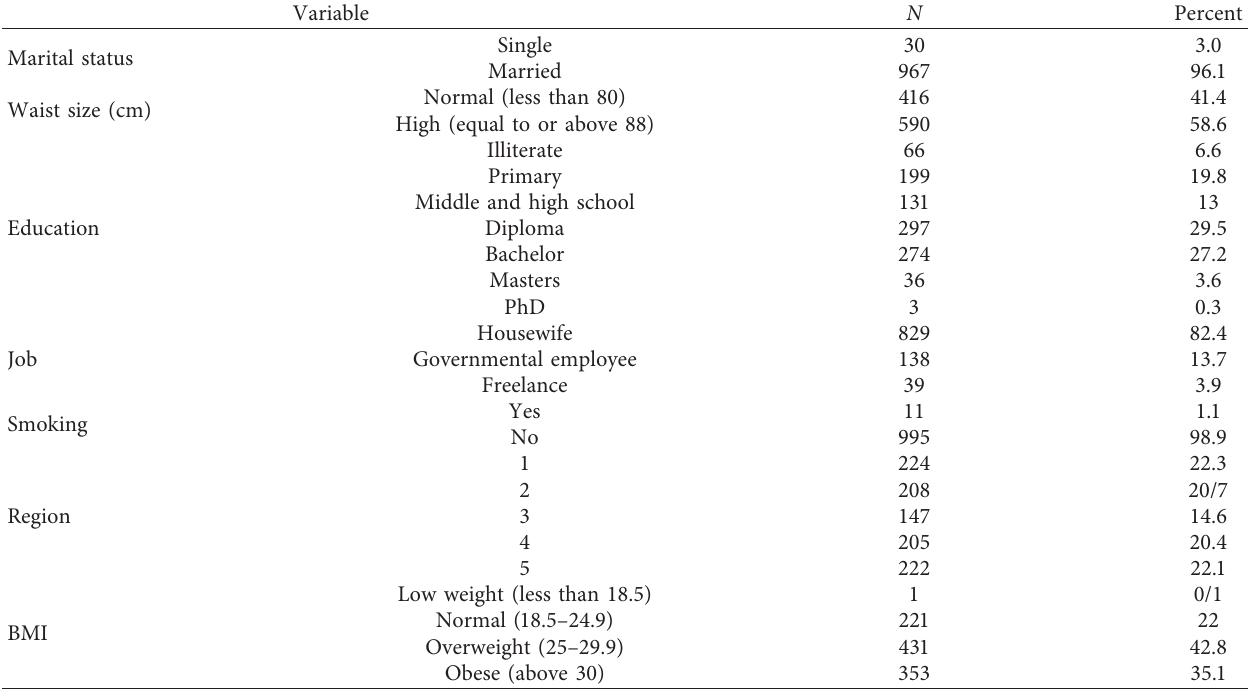
Table 1: Frequency distribution of the study’s demographic